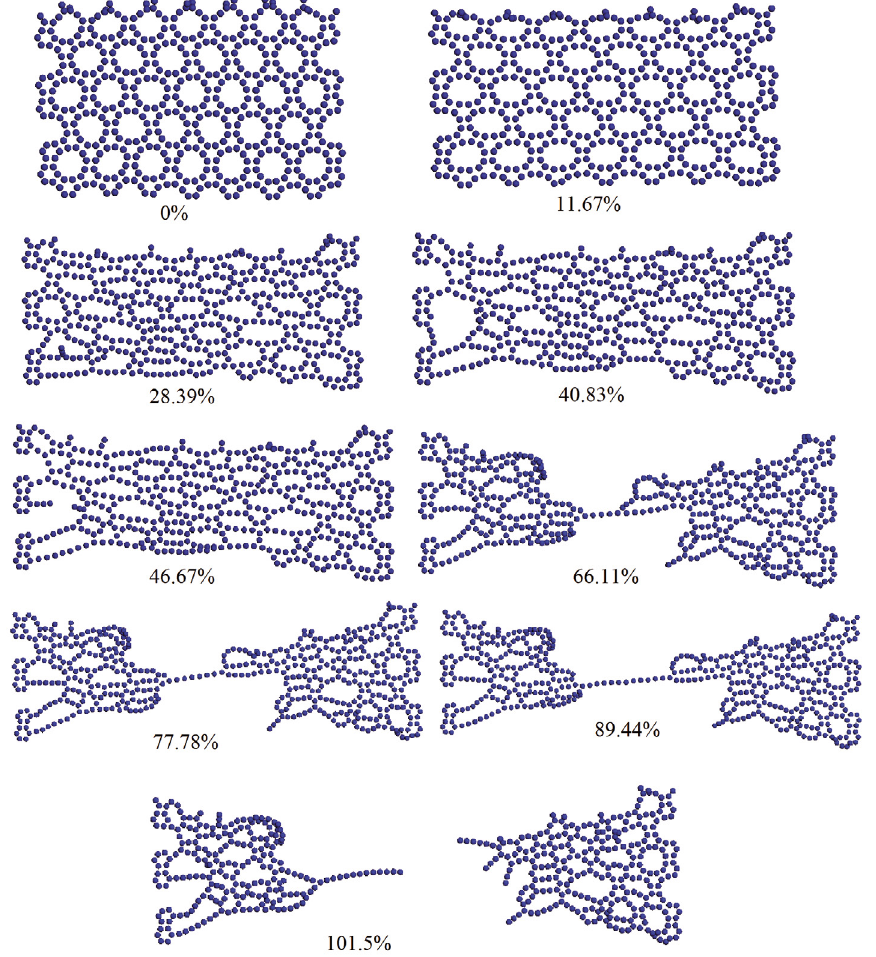
Figure 8: The shapes of a 30×50 Å 2 zigzag graphenylene at different strains